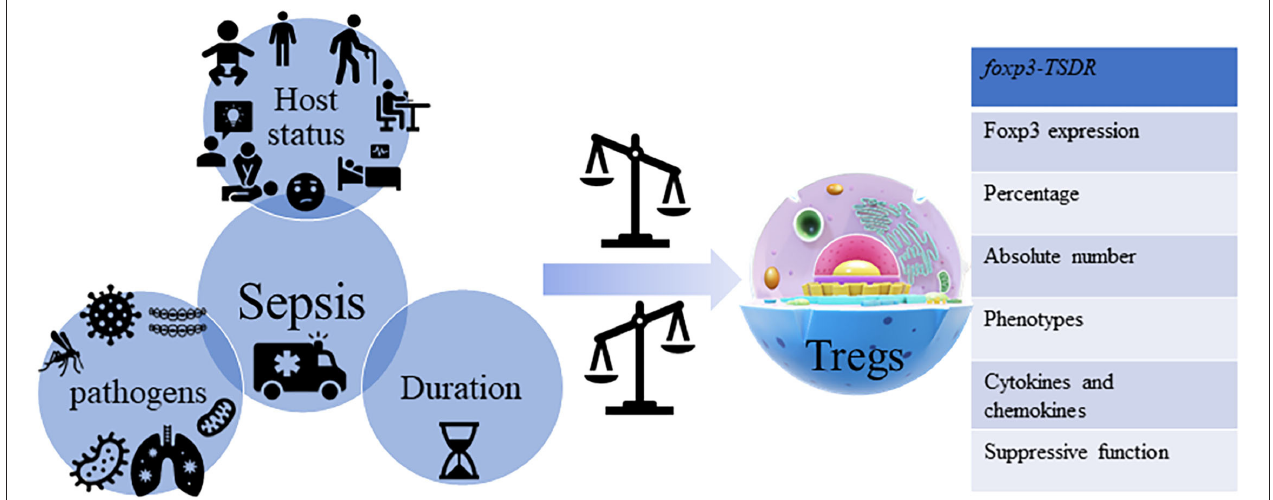
FIGURE 2 | Sepsis and T regs . Sepsis is a kind of multi-dimensional heterogeneous syndrome, which is not only reflected in the host’s demographics, chronic illness, comorbidities, laboratory abnormalities, infections position, patterns of organ dysfunction and severity of illness, and different types of the pathogen but also reflected in the protean host immune responses, where each is not identical. Sepsis influences the heterogeneous characteristics of T regs from the aspects of percentage (CD4 + CD25 + /CD4 + ), absolute number, phenotypes [cytotoxic T lymphocyte antigen (CTLA)-4, CD25, PD-1, CD43, B- and T-lymphocyte attenuator (BTLA), neuropilin (Nrp)-1, G protein-coupled receptor (GPR) 174, lymphocyte activation gene (LAG)-3 and membrane-associated transforming growth factor- β (TGF- β m + ), etc.], cytokines and chemokines [IL-10, TGF- β , IL-3, IL-35, and chemokine (C-X-C motif) ligand (CXCL)-4, etc.] secretion, and stability [Foxp3 expression, suppressive function, and methylation status of the foxp3-T regs -specific demethylated region ( TSDR ),